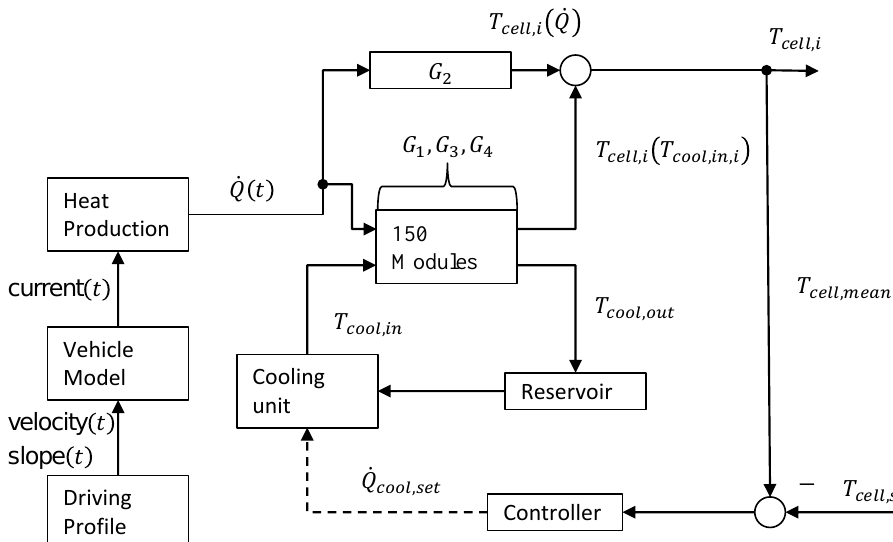
Figure 5. Calculation procedure for the battery system including a liquid-based thermal control loop. The driving profile and vehicle model determine the heat production. Transfer functions define the cell and coolant temperature. The coolant circulates between the battery, reservoir, and cooling unit. A controller closes the control loop considering the set and mean cell temperature.